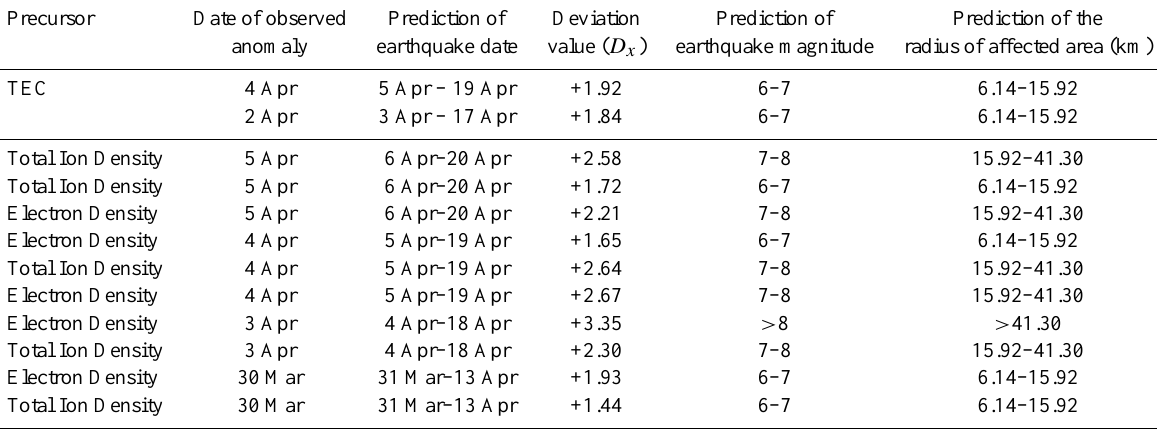
Table 6. Different precursors concerning L’Aquila earthquake (Akhoondzadeh, 2011). Precursor